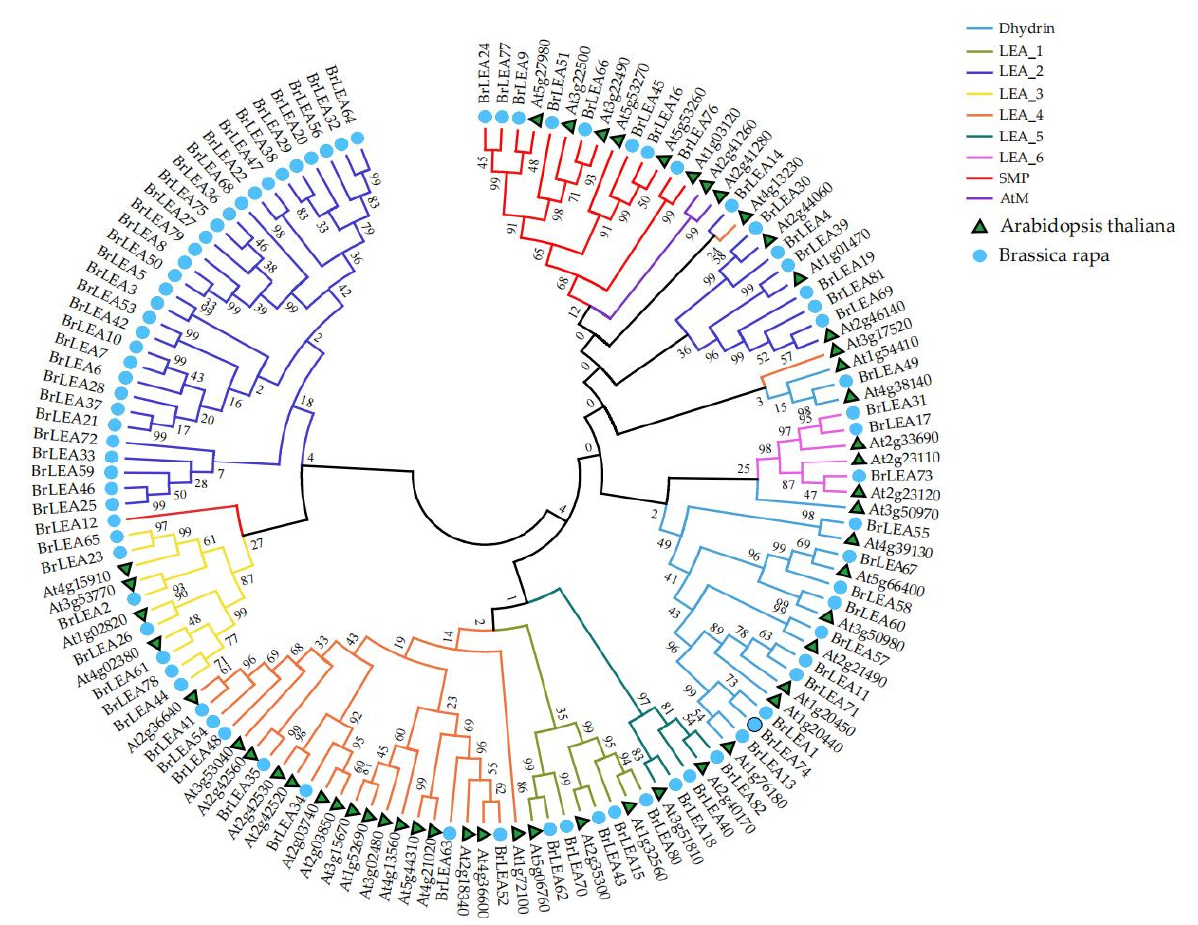
Figure 1. The phylogenetic tree relating to 51 Arabidopsis AtLEA [15] and 82 BrLEA gene family members in Chinese cabbage. The neighbor-joining phylogenetic tree of the BrLEA gene family is